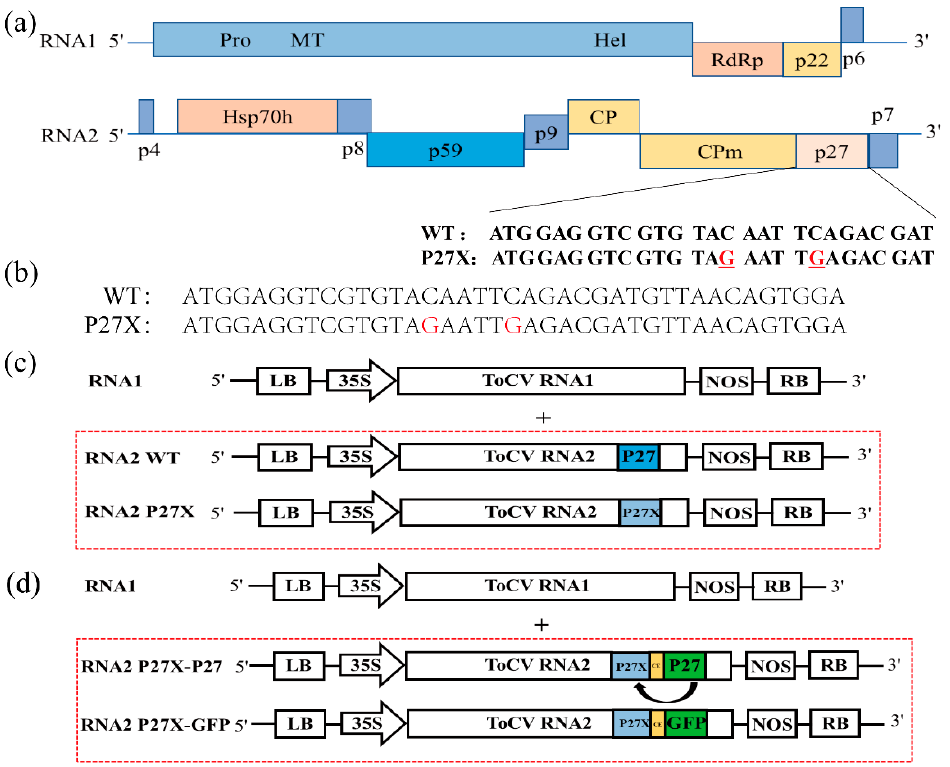
Figure 1. P27 promotes ToCV systemic infection in N. benthamiana plants. ( a ) Schematic diagram of the structure of the ToCV p27 base mutation. ( b ) Diagram of results of the sequencing of the p27 termination. ( c ) Schematic diagram of the genomic structure of ToCV-WT and ToCV-p27X. ( d ) Sche- matic map of the genomic structure of N. benthamiana infected with the ToCV-p27X system. ( e ) Four weeks after inoculation, WT, mutant, and anaplerosis ToCV caused symptoms in N. benthamiana . ( f ) Four weeks after ToCV immunosuppression, the expression of the ToCV CP protein in the leaves of the N. benthamiana system was detected by Western blot analysis. ( g ) Four weeks after inoculation, the accumulation of ToCV CP in N. benthamiana was detected by qRT-PCR. 3.2. Ectopic Expression of p27 Promotes PVX Systemic Infection in N. benthamiana Plants N. benthamiana was inoculated with PVX (pGR106) or pGR106-p27. At 14 days after inoculation, N. benthamiana, infected with pGR106-p27, showed more severe mosaic symptoms than N. benthamiana infected with pGR106 (Figure 2a). The total protein content was extracted, and the Flag antibody was used to detect the p27 protein by Western blot analysis (Figure 2b). The qRT-PCR results show that the expression of PVX CP in pGR106-